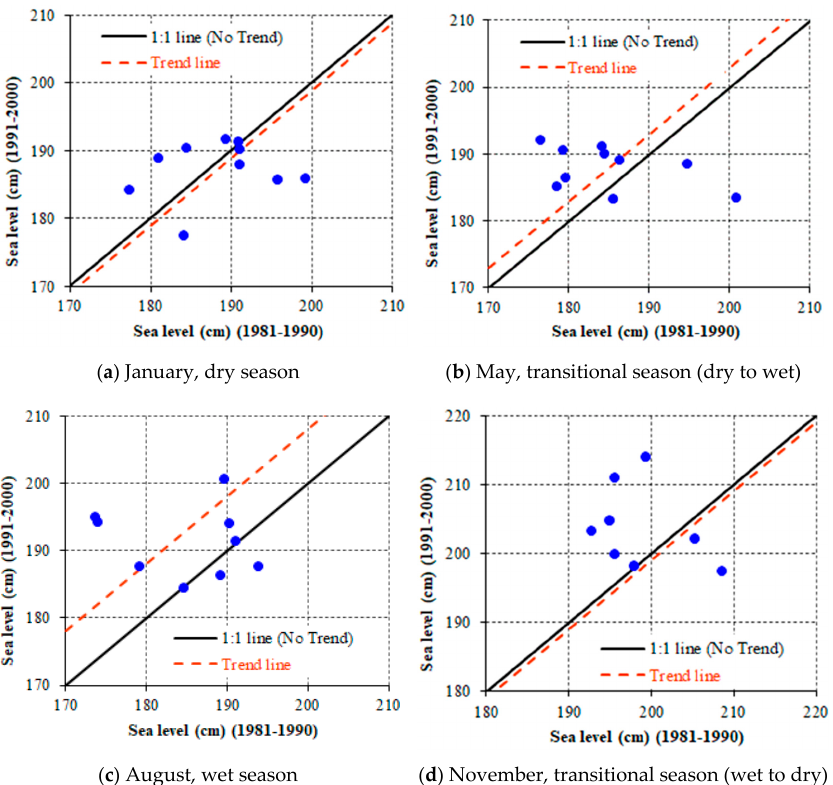
Figure 7. Results of the ITA on monthly sea level in different seasons for the Hon Dau station (1981–2000).